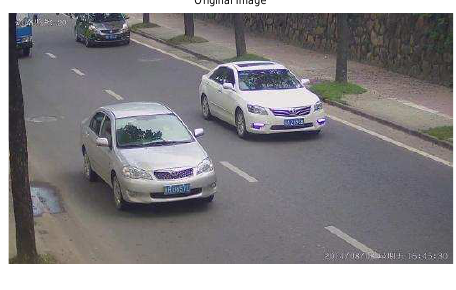
Fig. 13 Cars on the road (2).